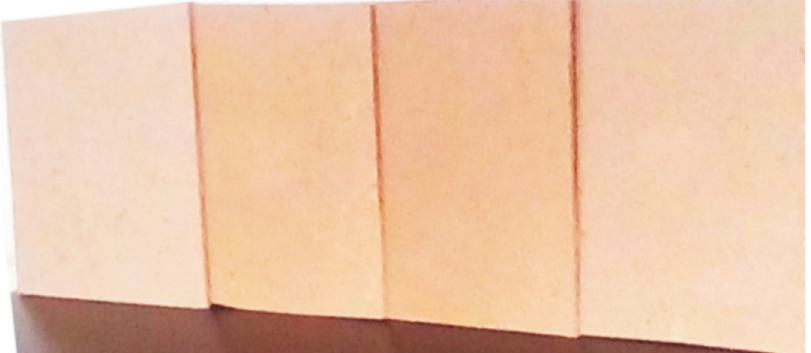
Figure 1. High-density fiberboards from industrial hardwood fibers bonded with UF resin and ammonium lignosulfonate; 910 kg·m − 3 target density, 6 mm thickness and three addition levels of ammonium lignosulfonate (6%, 8%, 10%).